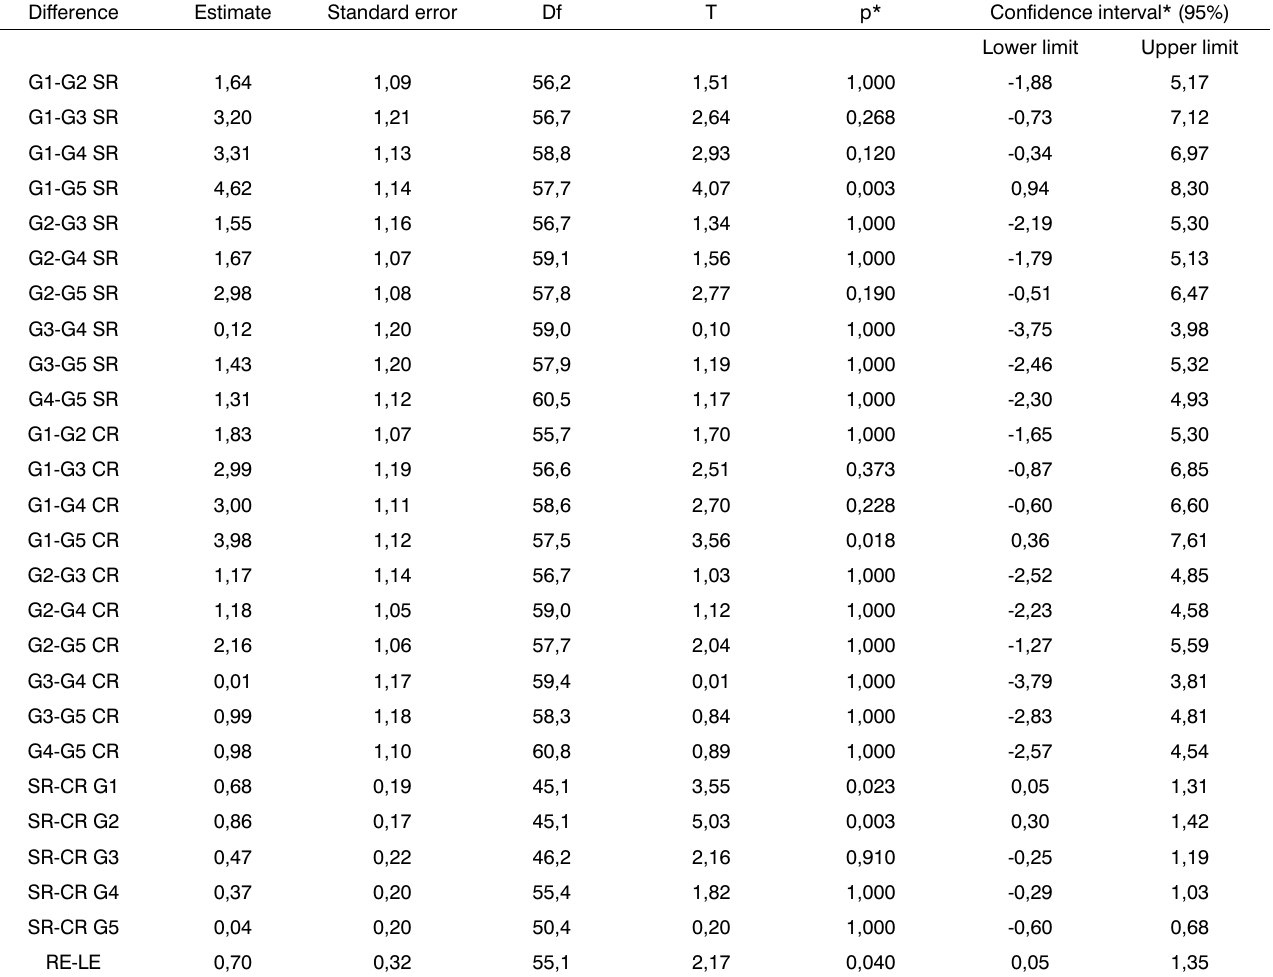
Table 2. Post hoc comparisons.